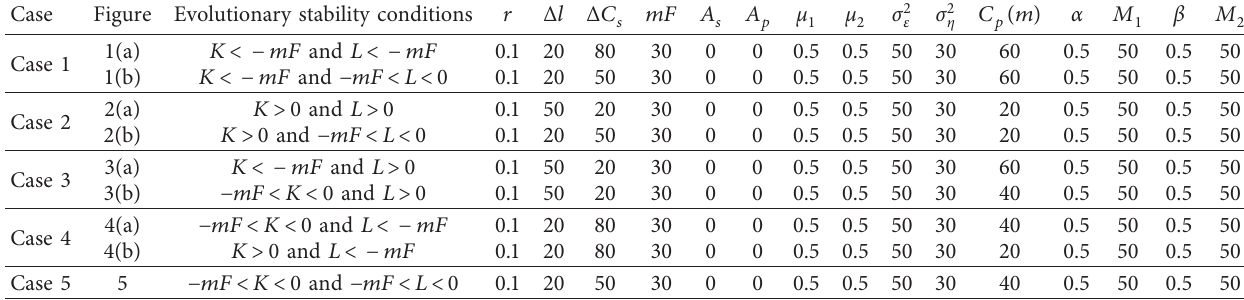
Table 5: Simulated values of parameters in the case of evolutionary stabilization strategy. Figure Evolutionary stability conditions